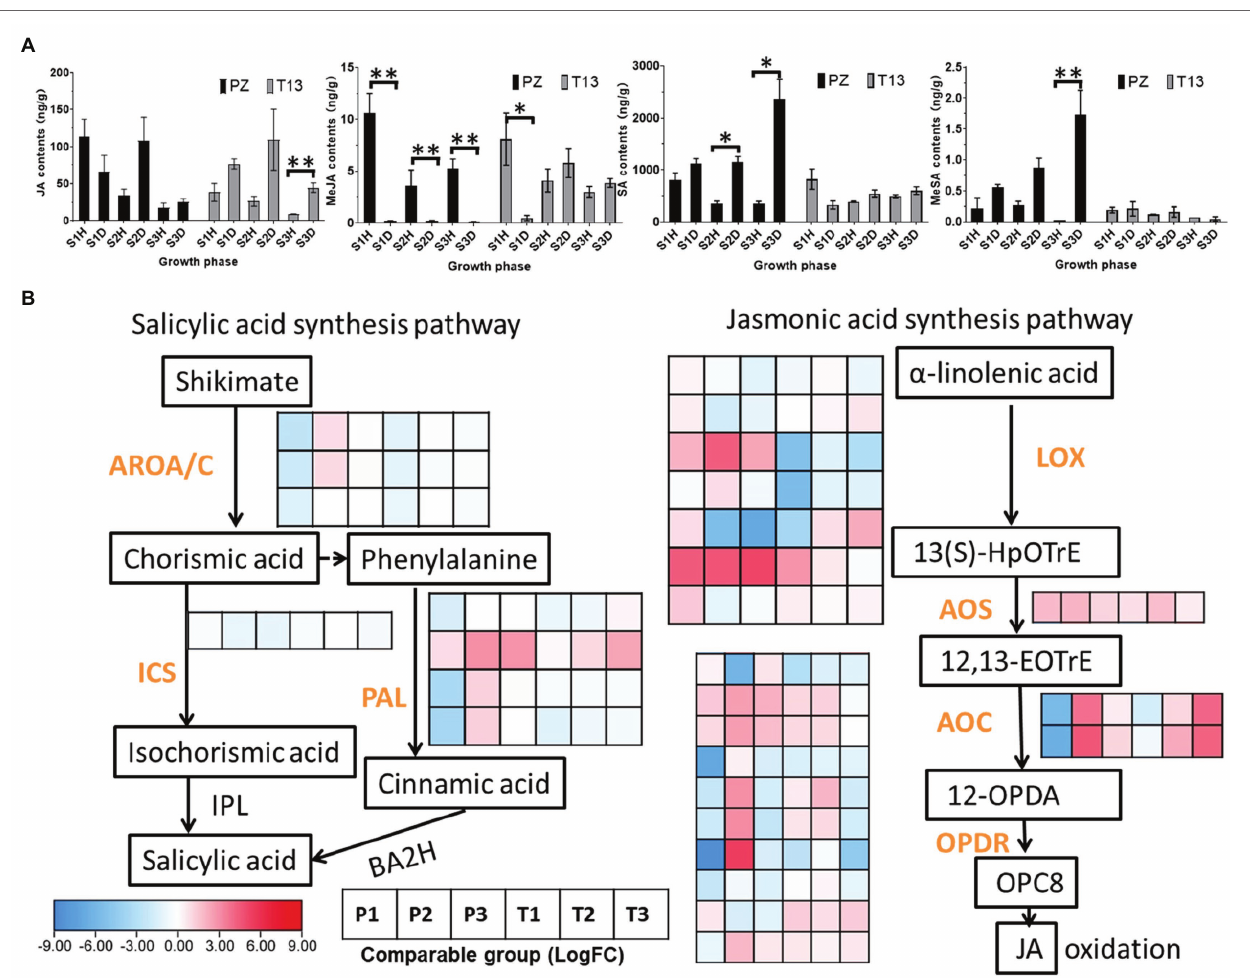
FIGURE 8 | Jasmonic acid (JA), MeJA, salicylic acid (SA), and MeSA changes and heatmap of DEGs involved in their synthesis pathway in “PZ” and “T13” leaves infected by phytoplasma. (A) JA, MeJA, SA and MeSA changes in three growth phases in healthy and diseased “Pozao” and “T13” with three biological replications. Error bar represents SE ( n = 3). (B) Heatmap of the expression level of key genes involved in the SA and JA synthesis pathways with Log2FC calculation. P1 and T1 represent the Log2(disease/healthy) results at growth phase S1 in “PZ” and “T13,” respectively. P2 and P3 and T2 and T3 have the corresponding meanings, as well as P1 and T1, respectively. ICS, isochorismate synthase; PAL, phenylalanine ammonia-lyase; LOX, lipoxygenase; AOS, allene oxide synthase; AOC, allene oxide cyclase; and OPDR, OPDA reductase. * p < 0.05; and ** p <